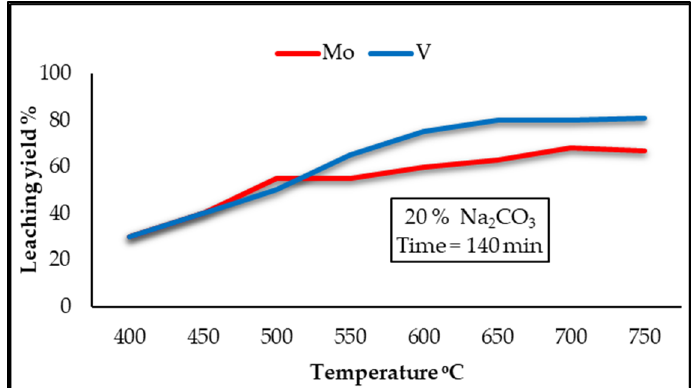
Figure 1 . Leaching of molybdenum and vanadium vs. temperature. Figure 1. Leaching of molybdenum and vanadium vs. temperature.